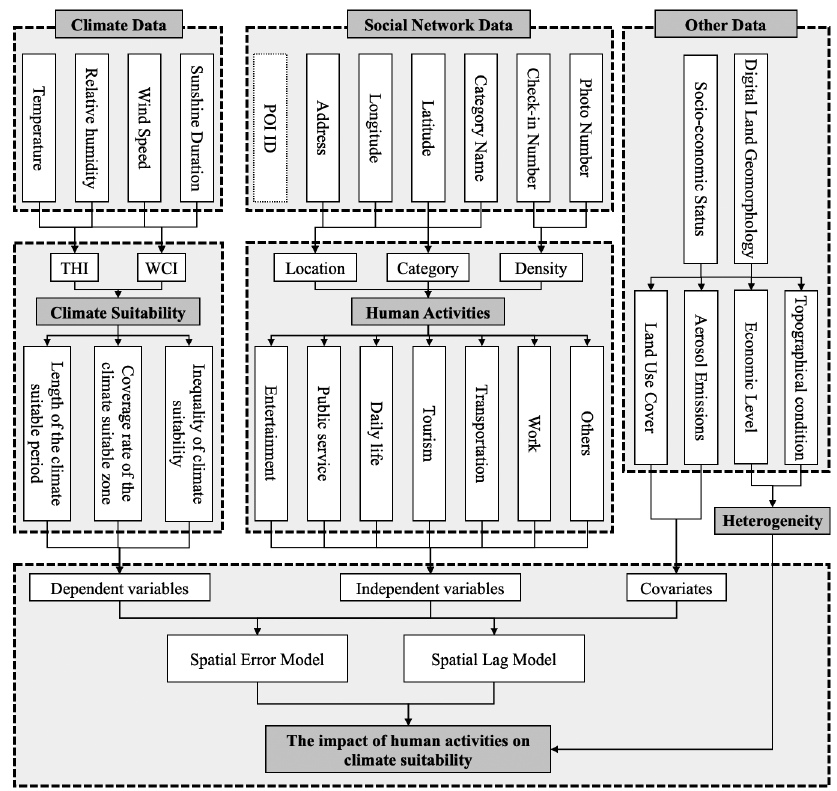
Figure 1. Technical roadmap of the impact mechanism of human activities over climate